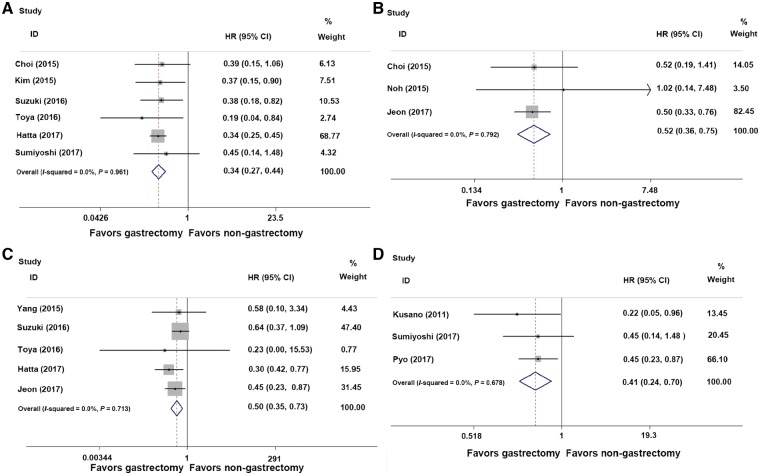
Forest plot assessing survival outcome comparing gastrectomy groups to non-gastrectomy groups. A, overall survival (HR = 0.34, P < 0.001); B, disease-free survival (HR = 0.52, P = 0.001); C, disease-special survival (HR = 0.50, P = 0.001); D, overall survival in the elderly patient subgroup (HR = 0.41, P = 0.001). HR, hazard ratio; CI, confidence interval.